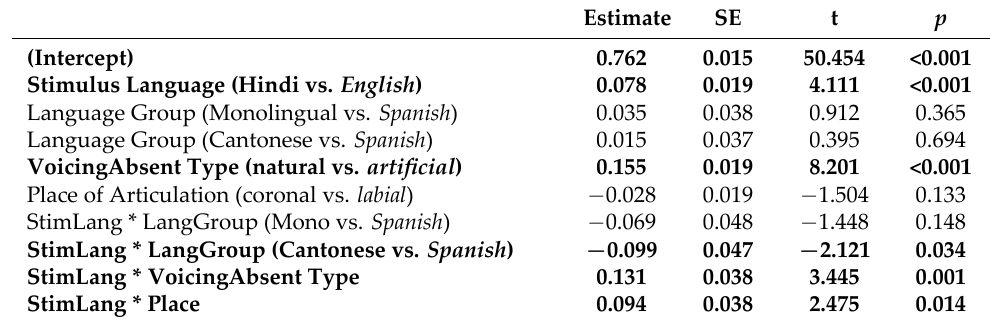
Table 6. Statistical results for the discrimination task. Effects in bold are significant ( p < 0.05). Estimate SE t